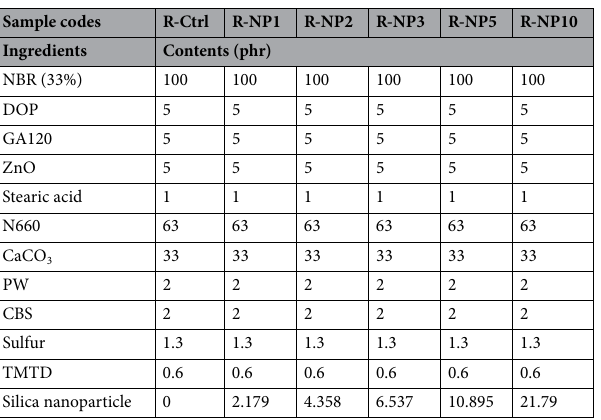
Table 1. Formulation of NBR compounds at different content of SNPs. Unit is in part per hundred parts of rubber (phr).